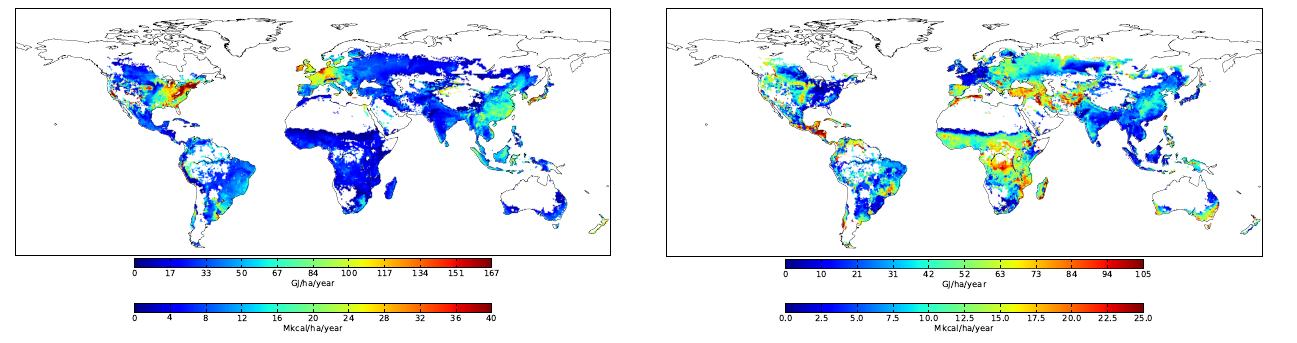
Fig. 5. Representative actual yield of crops modelled in the LPJmL model (dynamic crops), average over the 1999–2003 period.